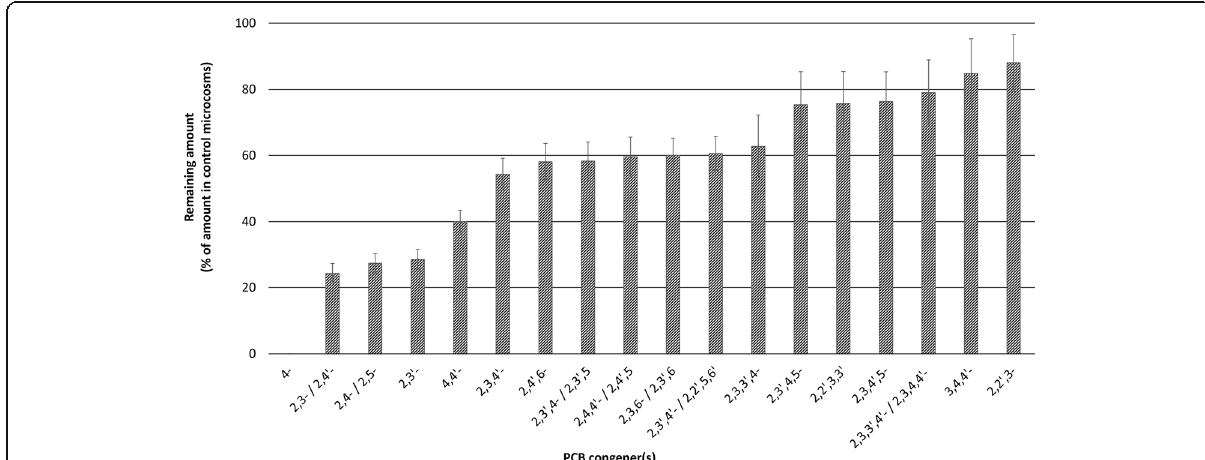
Fig. 4 Degradation activities of strain JAB1 towards PCB congeners. Biphenyl-induced JAB1 cells were co-incubated with commercial PCB mixture Delor 103 for 48 h, with individual congener depletion being determined by GC-MS. Degradation of the following biphenyl derivatives was monitored but not observed: 2,2 ′ -diCl, 2,2 ′ ,3-triCl, 2,2 ′ ,5-triCl, 2,2 ′ ,4-triCl, 2,2 ′ ,4,6 ′ -tetraCl, 2,2 ′ ,3,6-tetraCl, 2,2 ′ ,3,6 ′ -tetraCl, 2,2 ′ ,5,5 ′ -tetraCl, 2,2 ′ ,4,5 ′ -tetraCl, 2,2 ′ ,4,5 tetraCl, 2,2 ′ ,4,4 ′ -tetraCl, 2,2 ′ ,3,5 ′ -tetraCl, 2,2 ′ ,3,4 ′ -tetraCl, 2,3 ′ ,4 ′ ,6-tetraCl, 2,2 ′ ,3,4 tetraCl, 2,3,4 ′ ,6-tetraCl, 2,4,4 ′ ,5-tetraCl, 2,3 ′ ,4 ′ ,5-tetraCl, 2,3 ′ ,4 ′ ,5 ′ -tetraCl, 2,3 ′ ,4,4 ′ -tetraCl, 3,3 ′ ,4,4 ′ -tetraCl, 2,2 ′ ,3,4 ′ ,6-pentaCl, 2,2 ′ ,3,4,6 ′ -pentaCl, 2,2 ′ ,4,5,5 ′ -pentaCl, 2,3,3 ′ ,5 ′ ,6- pentaCl, 2,2 ′ ,4,4 ′ ,5 pentaCl, 2,2 ′ ,3,4 ′ ,5 ′ -pentaCl, 2,2 ′ ,3,4,5 ′ -pentaCl, 2,3,3 ′ 5,5 ′ -pentaCl, 2,3,3 ′ ,4 ′ ,6-pentaCl, 2,2 ′ ,3,3 ′ ,4-pentaCl,